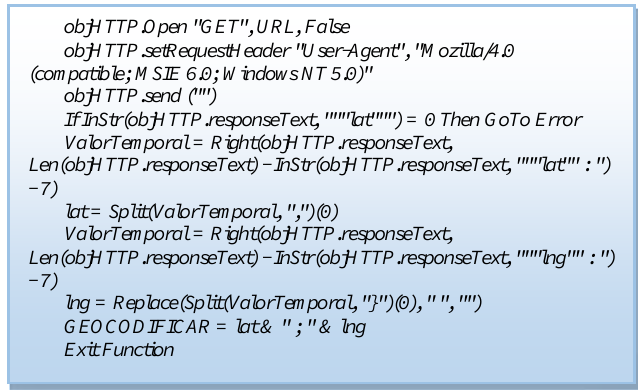
Table 4: Fragment of the codification